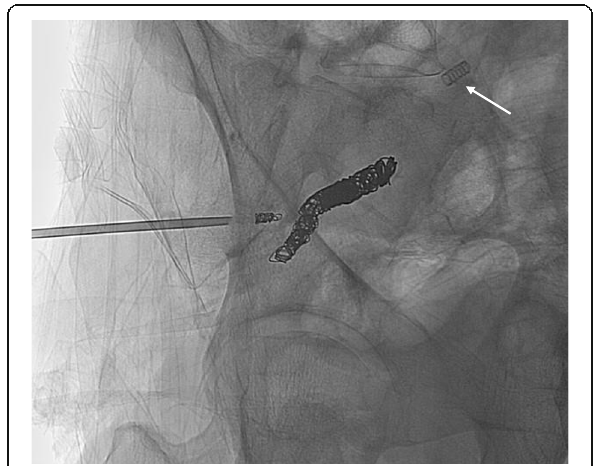
Fig. 3 Further embolization of the bone marrow tract with coils and gelatin sponges. The same spring-like radio-opacity was again noted (white arrow) in reference to the pre-embolization angiogram, not to be confused with coil